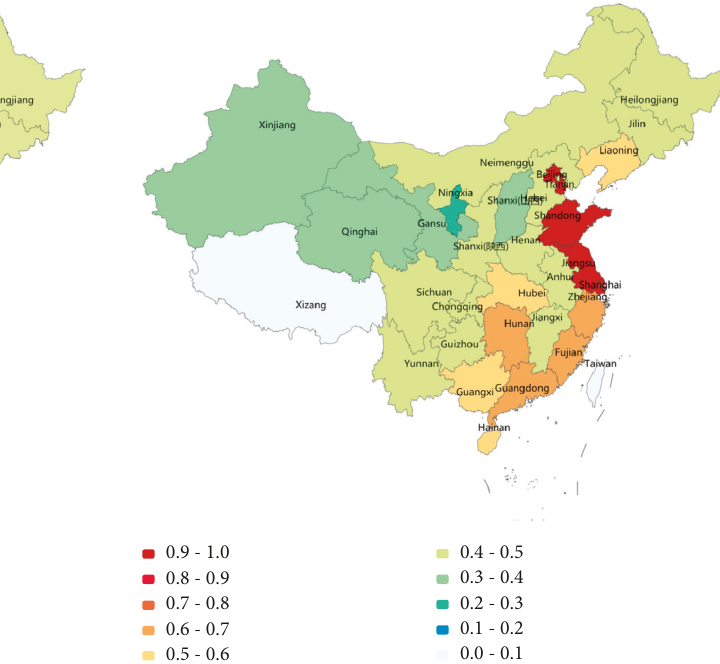
Figure 6: 2017 EEE value in China.